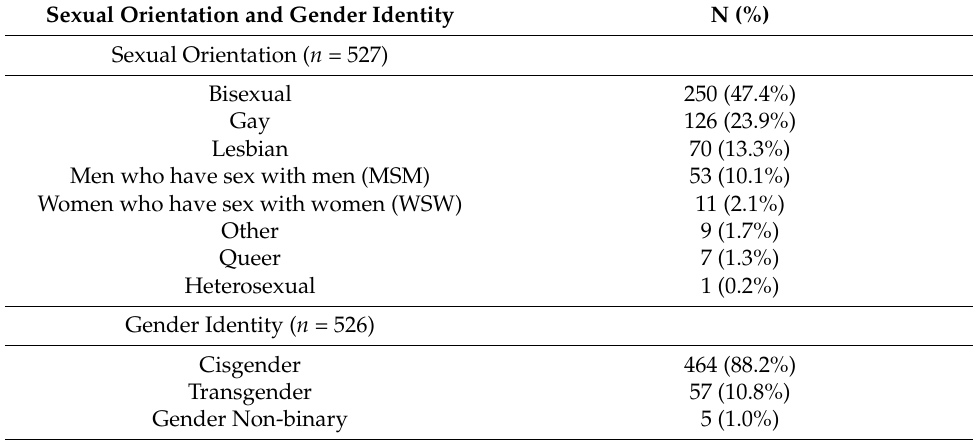
Table 2. Sample Sexual Orientation and Gender Identity. Sexual Orientation and Gender